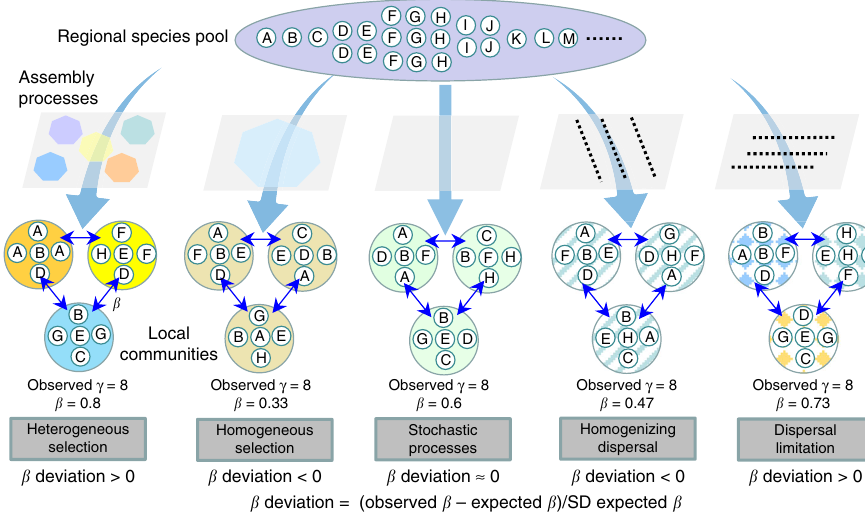
Fig. 2 Hypotheses tested to illuminate the underlying drivers of bacterial β diversity patterns. Scenario I: If regional species pools dominate β diversity pattern, then β diversity will vary depending on γ diversity and the distribution of species abundance. For example, with the increasing γ diversity along the latitudinal gradient, β diversity increases accordingly. In this study, γ diversity refers to regional species richness (a size of species pool), while regional species pool re fl ects both regional species richness and species abundance distribution. Scenario II: If local community assembly processes dominate β diversity pattern, the variation in β diversity mainly depends on local community assembly processes. For instance, β diversity is different due to different community assembly processes even when the observed γ diversity is consistent. β deviation is calculated as the difference between the observed and mean expected β diversity, divided by the standard deviation (SD) of expected values. Throughout the fi gure, letters represent hypothetical species. Large ovals represent regional species pools and small circles with letters represent local communities that comprise a subset of species from the regional species pool. The arrows going from the species pool to the local communities in scenario I re fl ect random sampling. The arrows passing through each respective condition in scenario II represent heterogeneous selection, homogeneous selection, stochastic processes, homogenizing dispersal and dispersal limitation, respectively. Here, stochastic processes refer to the ecological processes that give rise to β diversity patterns that are indistinguishable from random chance alone, such as ecological drift 35 . The shaded areas containing several hexagons represent environmental conditions, where hexagons with different colors represent environmental heterogeneity; a hexagon of a single color represents homogeneity. Dash lines perpendicular to the direction of arrows in the shaded area represent the dispersal limitation; dash lines parallel to the direction of arrows represent homogenizing exhibited a unimodal distribution (Fig. 3a, c and Supplementary (Fig. 3b and Supplementary Fig. 2b). The reasons for the lack of Fig. 3a, c), which aligns with the global general pattern of soil an apparent latitudinal gradient in β diversity are manifold, bacteria 3 , where bacterial species richness peaks at mid-latitudes among which is that diversity and abundance of bacterial com- and declines towards the poles and the equator. As expected, β munities are constrained primarily by edaphic variables 2,7,13 . Our results also showed that variation in β diversity along the diversity of soil bacteria did not exhibit a latitudinal gradient